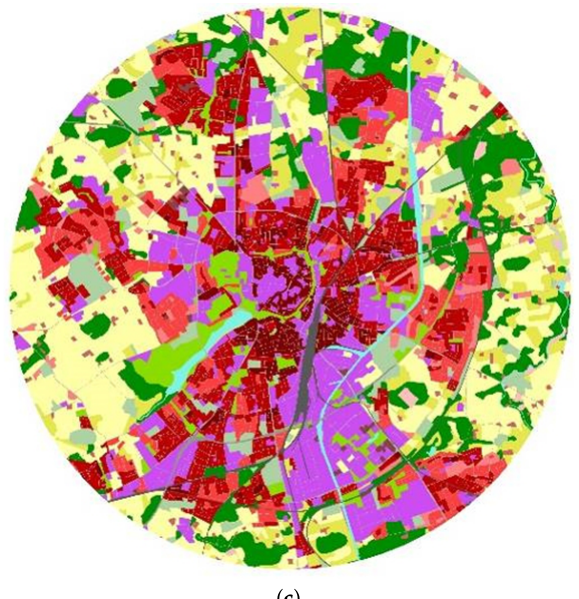
Figure 9. An interesting triplet of look-alike cities. ( a ) Odense; ( b ) Metz; ( c ) Münster. (Source: [29],